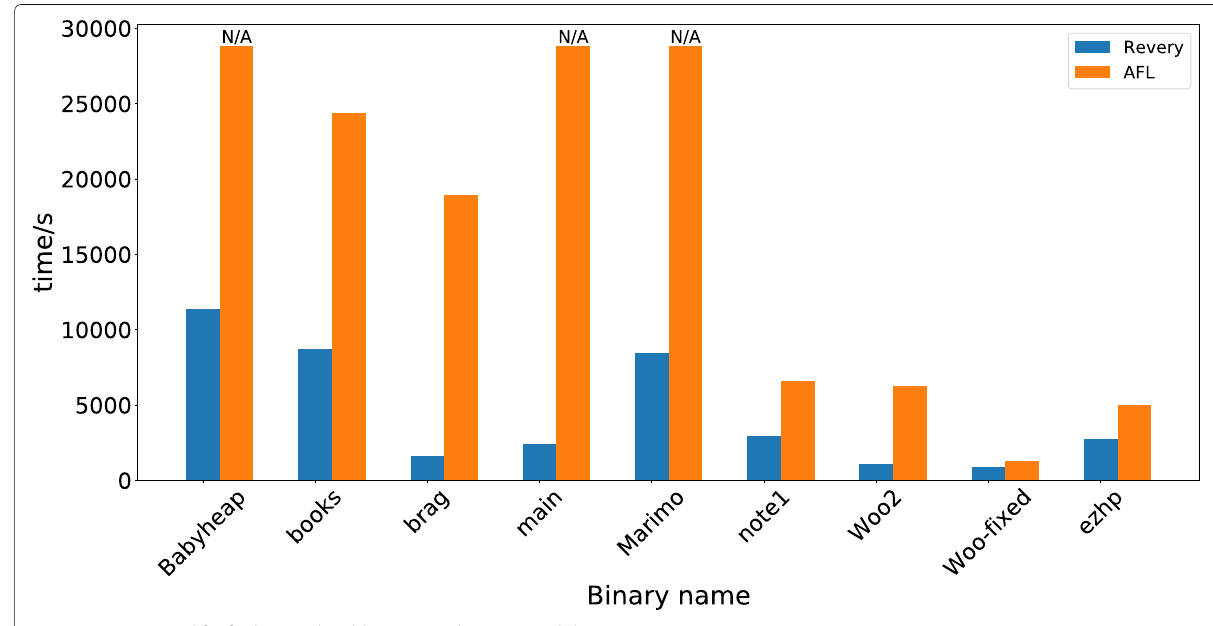
And only in one program (i.e., note1 ) the symbolic execution engine of Driller is invoked. This is probably because driller is designed for CGC programs and has some bugs for ELF binaries.